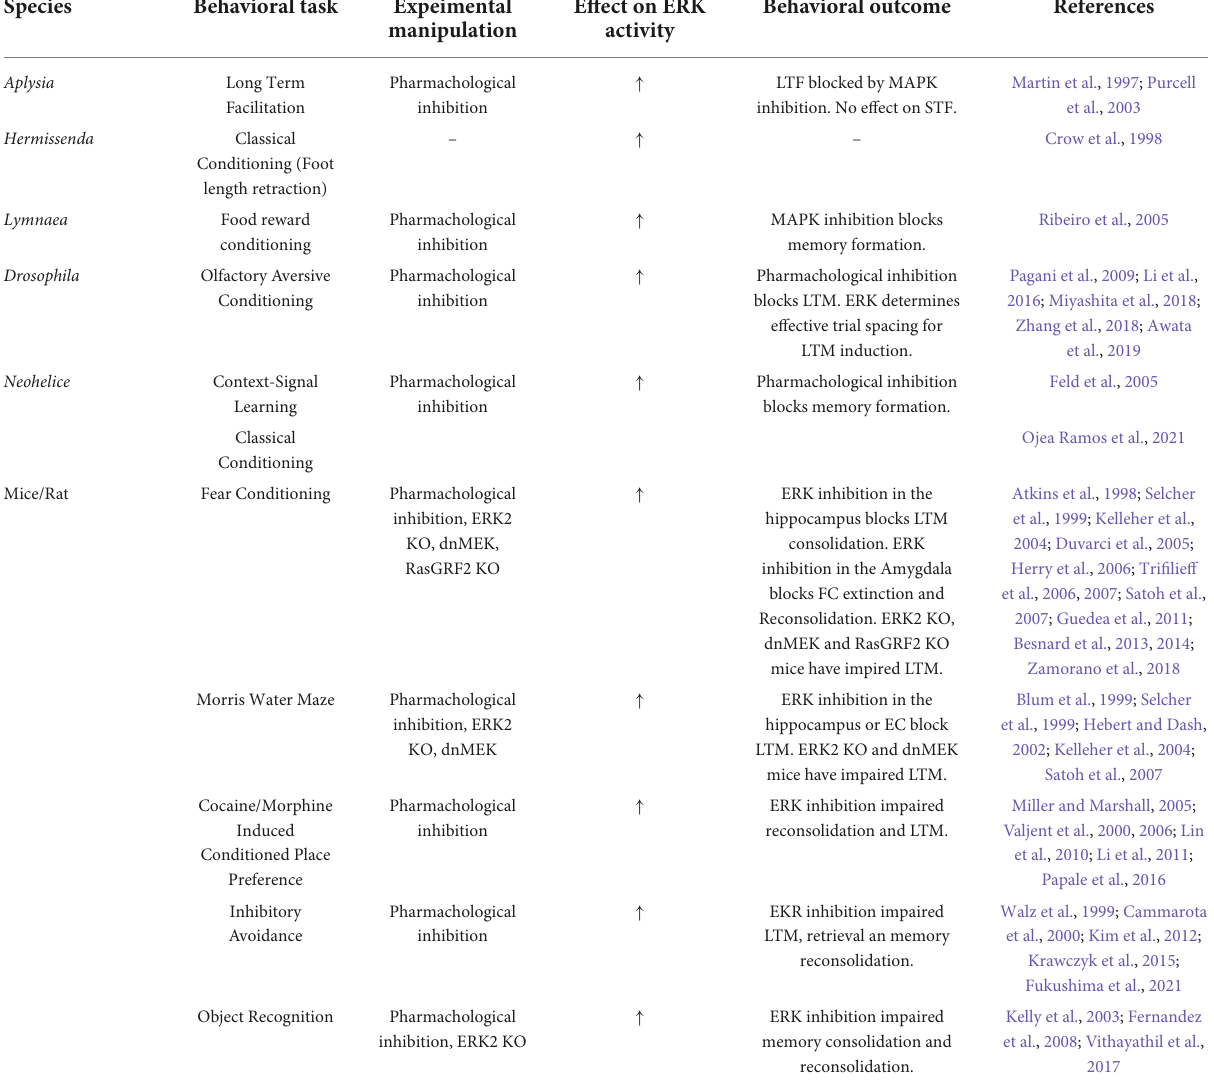
TABLE 2 Outline of research associating ERK activity to different forms of learning and